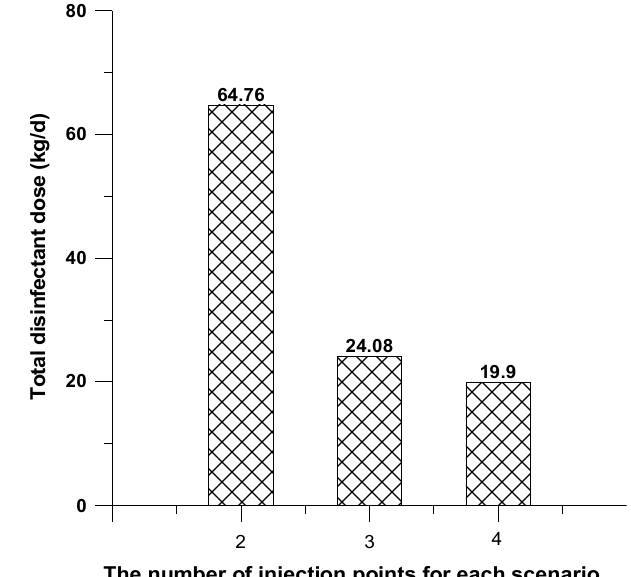
Figure 8. Total injection dose for each scenario (P-City, Network 1).